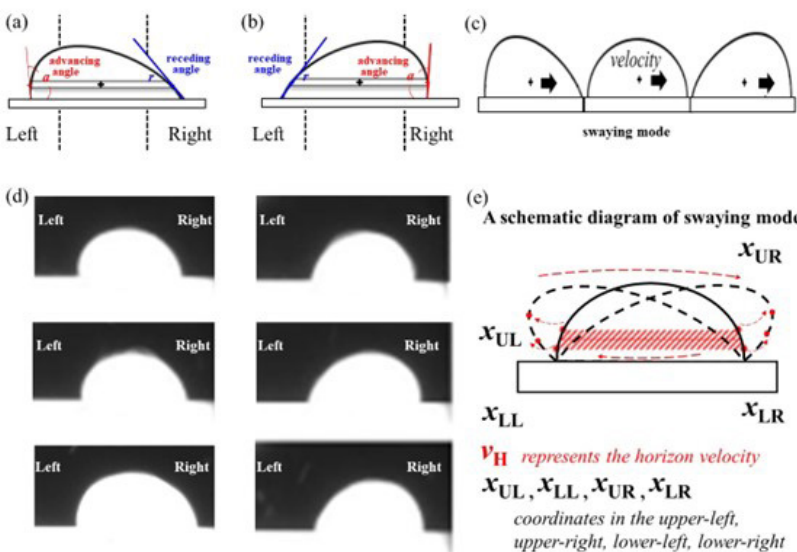
Figure 3. Imagery examples of two types of contact angle hysteresis in the kinetic studies of Al/SiC wetting under the excitation of 20 kHz ultrasonic wave. After showing advancing/receding angle alternatively (a) on the left or (b) on the right side, (c) a schematic of the mechanism of hysteresis, (d) Images with contact angle hysteresis phenomenon, (e) an illustration of changing the coordinate of both sides by the ultrasonic treatment.